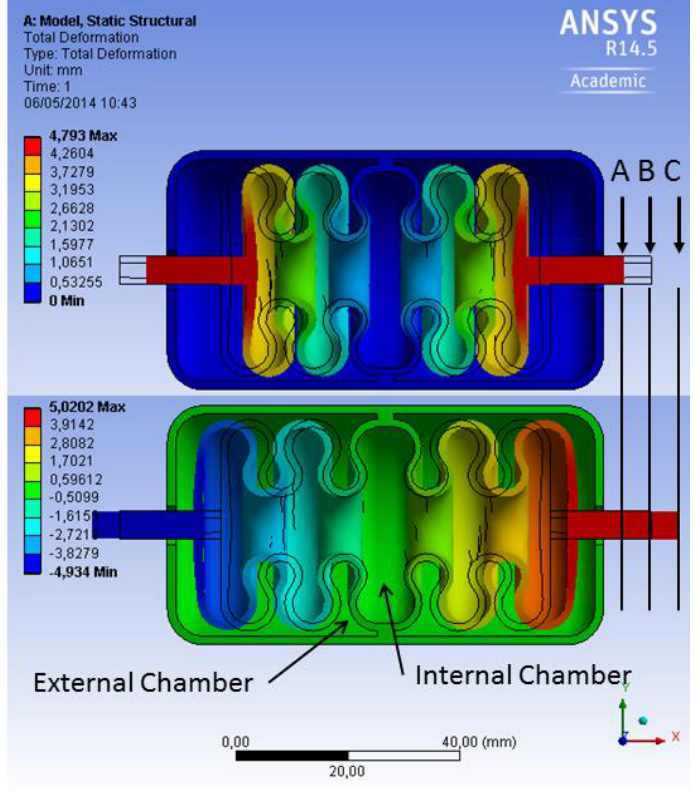
Figure 4. Pneumatic AM actuator with double effect. The picture at the top shows the result when the internal chamber is at atmospheric pressure and the external is with 0.4 MPa. In the second picture, the internal chamber is with 0.4 MPa and the external with atmosphere